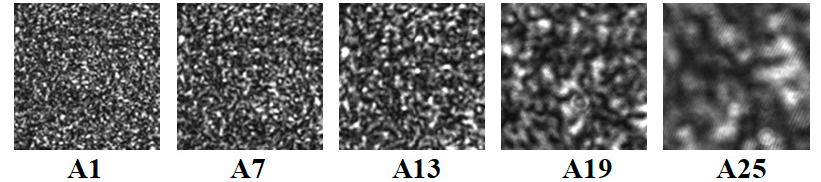
Figure 5. Speckle patterns collected at different defocusing degrees.